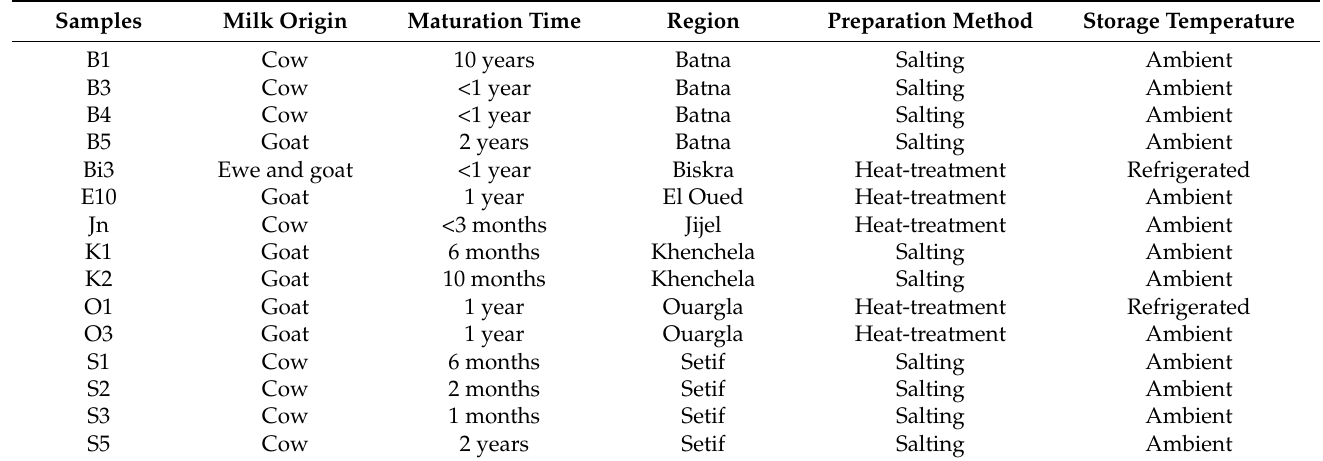
Table 1. Description of collected Smen